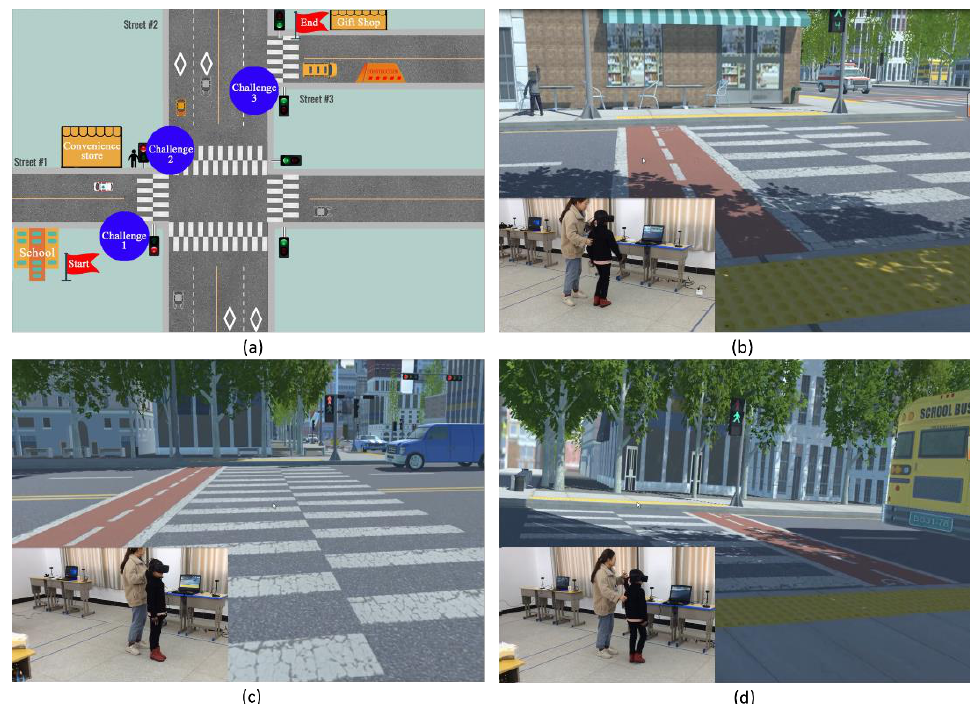
Figure 1. ( a ) visualization of three challenges in the VR program; ( b ) C1: participants need to cross the street safely to meet with an avatar friend; ( c ) C2: participants need to correctly interpret the meaning of a flashing green pedestrian light and make decisions regarding whether to cross a wide street; ( d ) C3: participants need to delay their street-crossing activity and wait for a backing school bus to drive away.